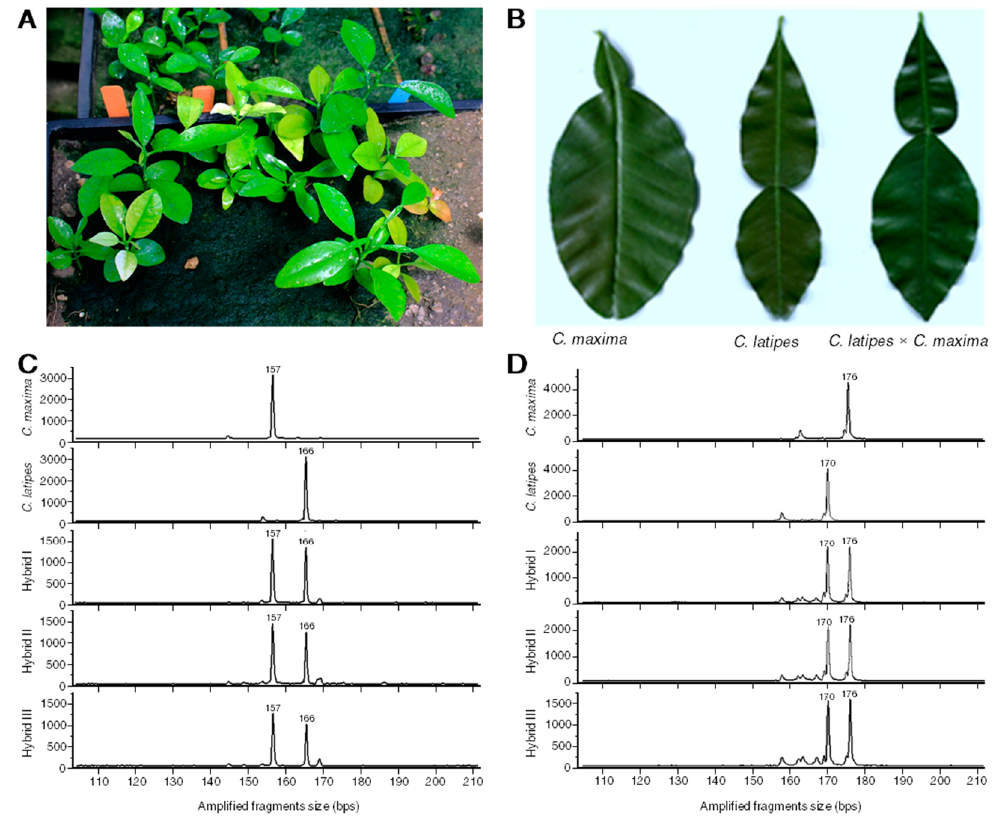
Figure 1. Selection and confirmation of new hybrids. ( A ) Selection of new hybrids based on their growth in calcareous soil (pH 8) that was inoculated with Phytophthora nicotianae and P. palmivora cultures. ( B ) Leaf morphology of the new hybrids evaluated in this study and their parents, Citrus latipes and C. maxima. ( C , D ) Electropherograms example of expressed sequence tag-simple sequence repeat (EST-SSR) using two SSR primers (loci; CX6F06Y and CX6F10R, respectively) of Citrus latipes and C. maxima and their corresponding sexual hybrids (Hybrid I, Hybrid II and Hybrid III). Numbers above the peak indicate the size of the amplified fragments measured in base pairs (bps).